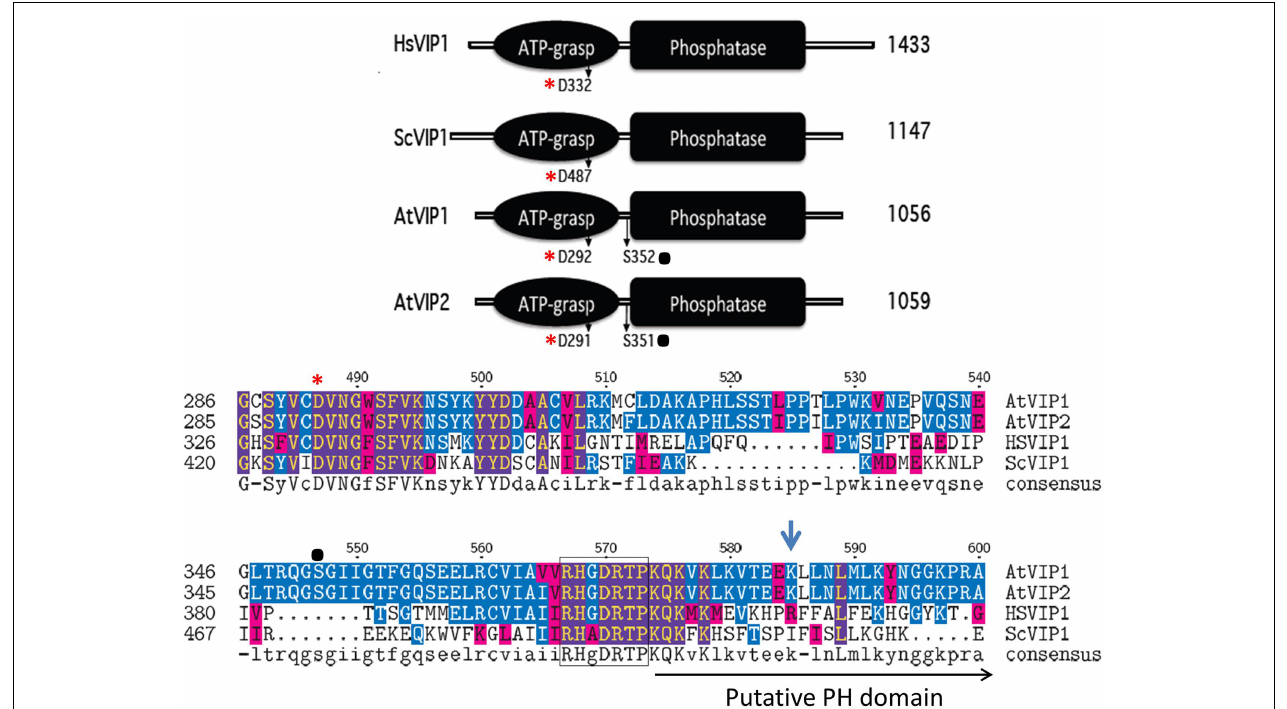
FIGURE 4 | Schematic alignment of the kinase and phosphatase domains of VIPs. The ATP grasp/RimK/ kinase (ATP-grasp) and the histidine acid Phosphatase (Phosphatase) domains within the VIP proteins from Homo sapiens (Hs, Genbank AAH57395), Saccharomyces cerevisiae (Sc, NP_013514) and Arabidopsis thaliana ( AtVip1 Gene ID, 821297; AtVip2 Gene ID, 831359). The red asterisks denotes in both panels the conserved aspartic